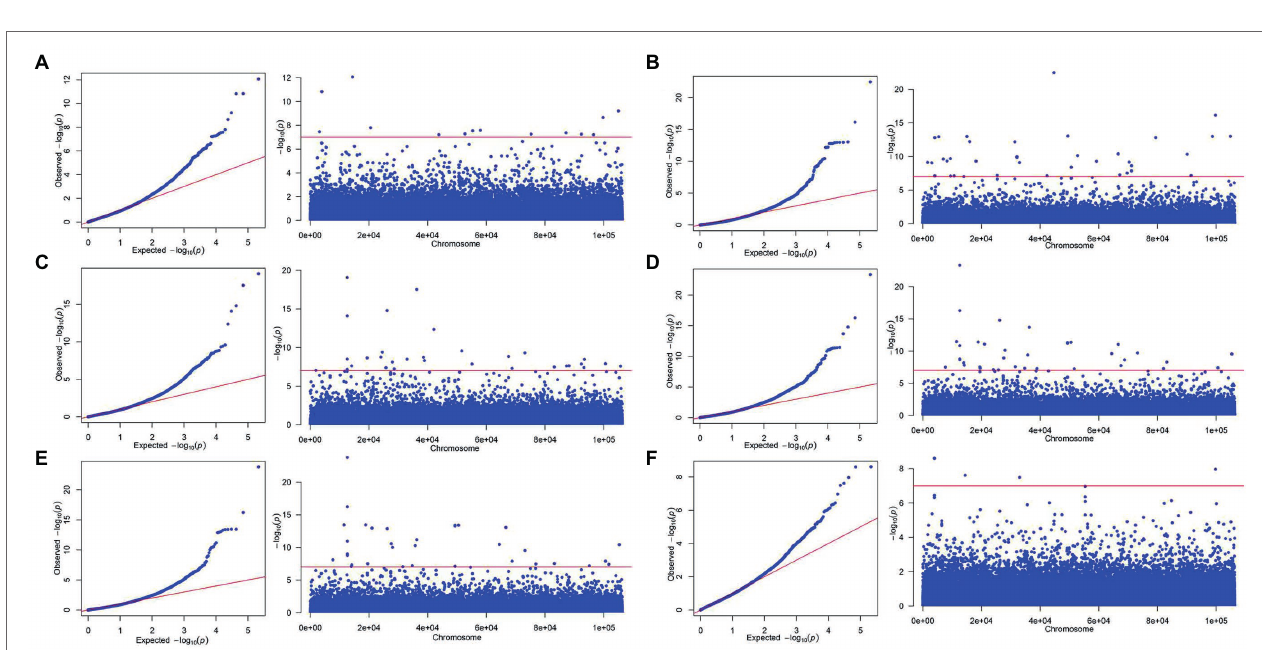
FIGURE 3 | The qq-plot and manhattan of genome-wide association studies for growth-related traits based on mixed linear model (MLM). (A) H, (B) DBH, (C) V, (D) P, (E) WBD, and (F) HY.